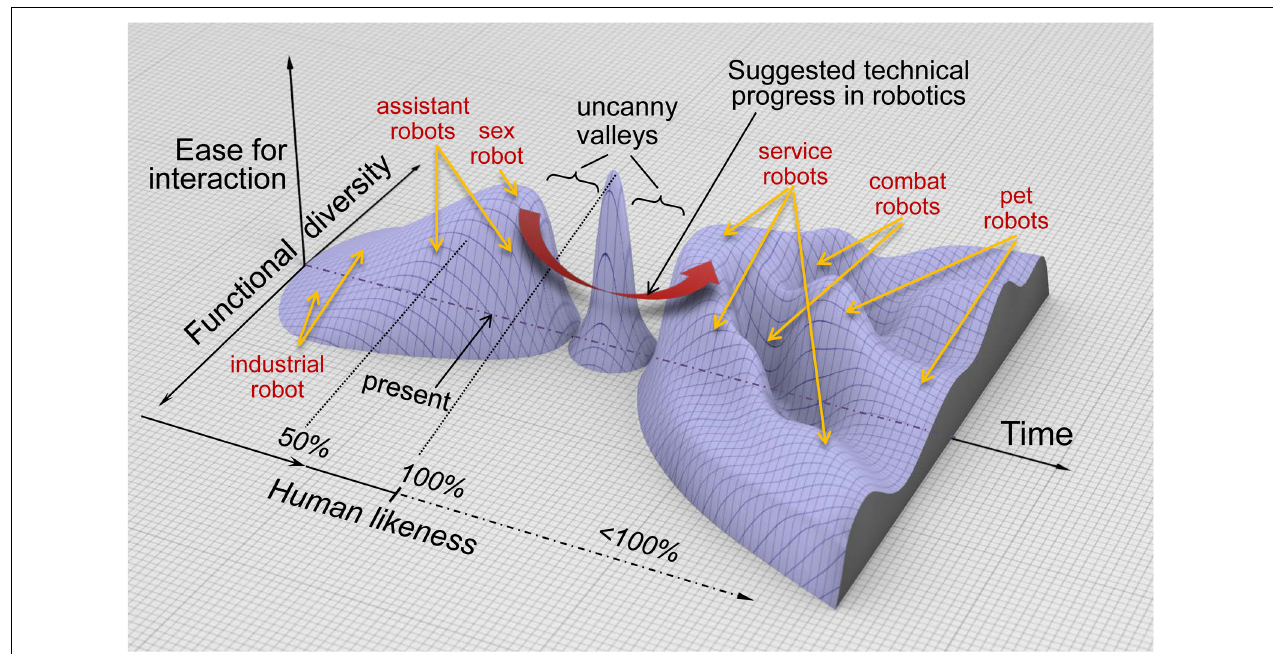
FIGURE 3 | An ethorobotic concept of emerging human-robot interaction. Based on Mori’s idea, the present situation and the envisaged progress of social robotics are shown in a three-dimensional space to separate human-likeness, functionality and ease of interaction. After the peak and the second uncanny valley, robots are likely to evolve into a diversity of morphologies and behaviors that, depending on their functions, gradually move away from perfect human likeness. The wide curved arrow indicates the possible detour for social robotics by moving directly from the present state to less humanlike robots with diverse functionality retaining high-level capacity for social interaction with humans. The labels on the terrain are only for informative purposes and do not necessarily refer to actual existing robots.